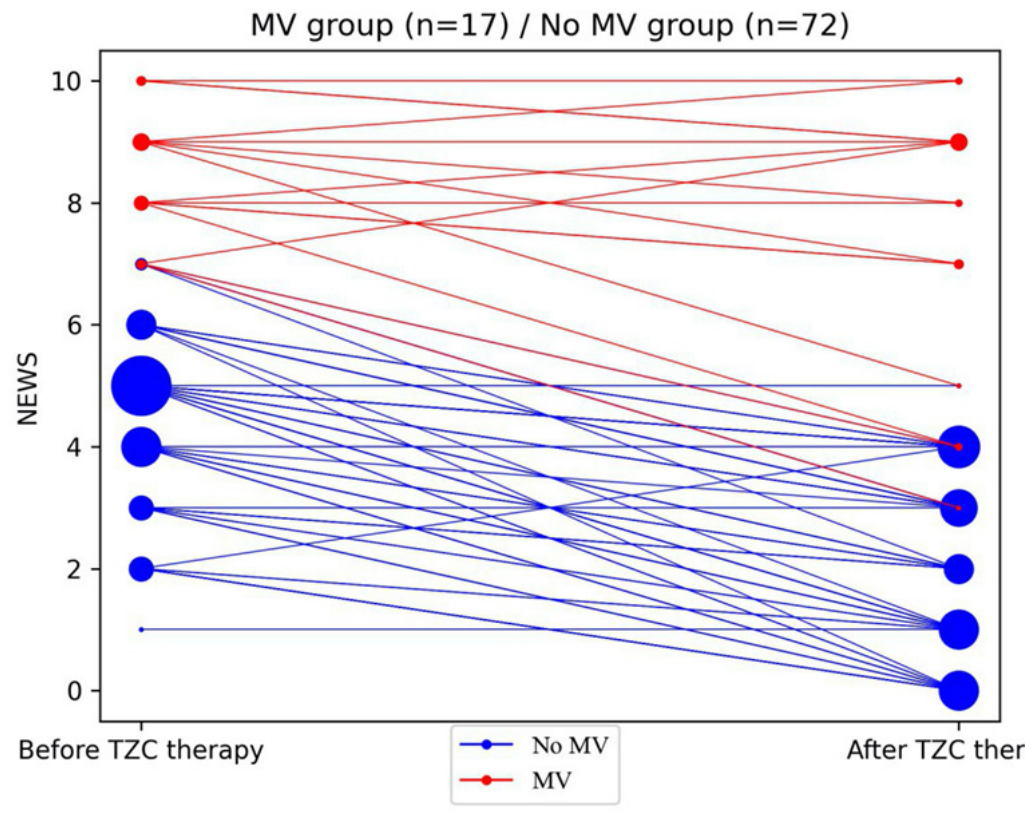
Figure 2 . Changes in NEWS2 severity score after TCZ